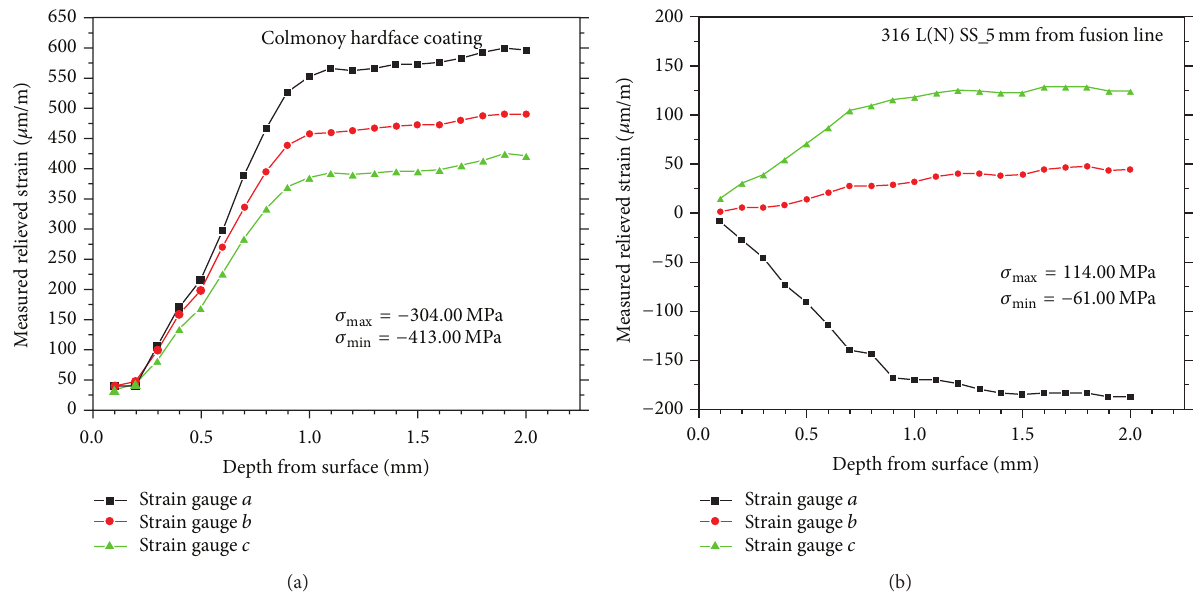
Figure 5: (a) Measured relieved strain versus depth from the surface in the colmonoy region. (b) Measured relieved strain versus depth from the surface in the base metal region.